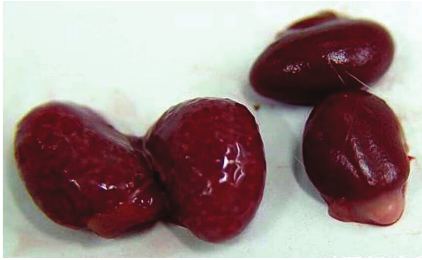
Figure 3: Gross observation of kidneys. The right two kidneys were the normal controls and the left swollen kidneys covered with petechiae were from infected mice.